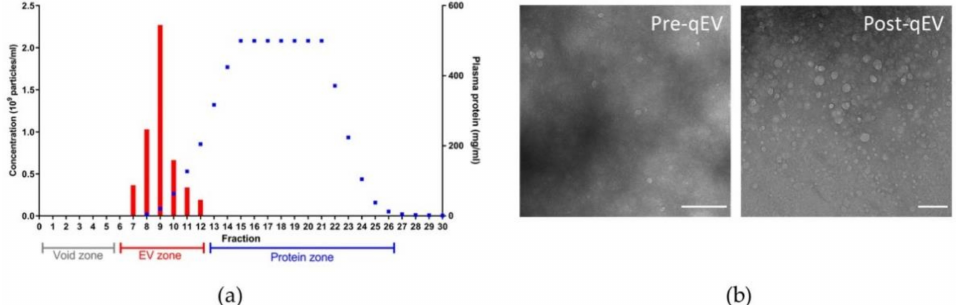
Figure A2. Plasma size exclusion chromatography (SEC) fractionation using qEV (IZON) columns. ( a ) Example fractionation profile from a qEV/35 nm SEC column loaded with 1 mL plasma. Con- centration of particles (red bars) was measured using nanoparticle tracking analysis (NTA) with a ZetaView twin instrument (Particle Metrix). Total protein was measured using a BCA Protein Assay Kit for low concentrations (Abcam, blue points). The first 3 mL are void containing no particles (grey, void zone), plasma EVs typically elute in the next 3 mL (EV zone, red), and proteins in the remaining 7 mL (protein zone, blue). Sample n = 1. ( b ) Example of a plasma sample imaged using transmission electron microscopy (TEM) pre- and post-processing using a qEV/35 nm SEC column. Post-processing, extracellular proteins (white haze) are removed and intact, spherical vesicles can be visualized. Scale bar (200